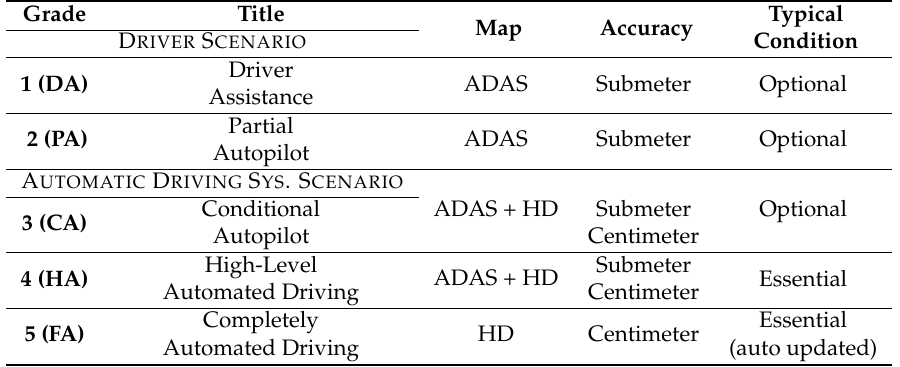
Table 1. Maps for different levels of Intelligent Connected